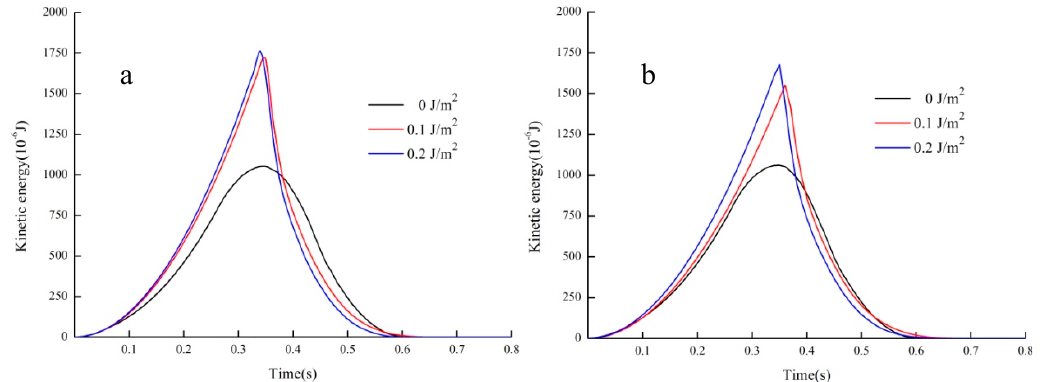
Figure 8. The total kinetic energy of wet soil granular flow, the ( a ) and ( b ) diagrams represent results of soil-grain diameters of 0.7 mm and 1 mm respectively.